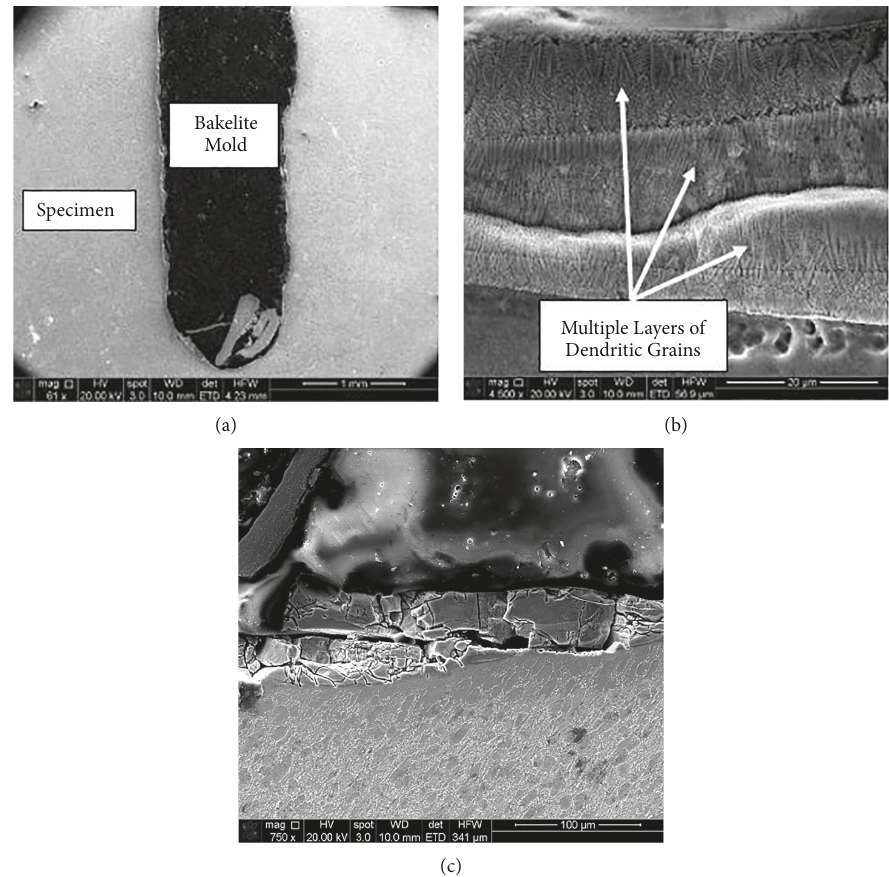
Figure 6: SEM micrographs of electrode wear study for titanium.